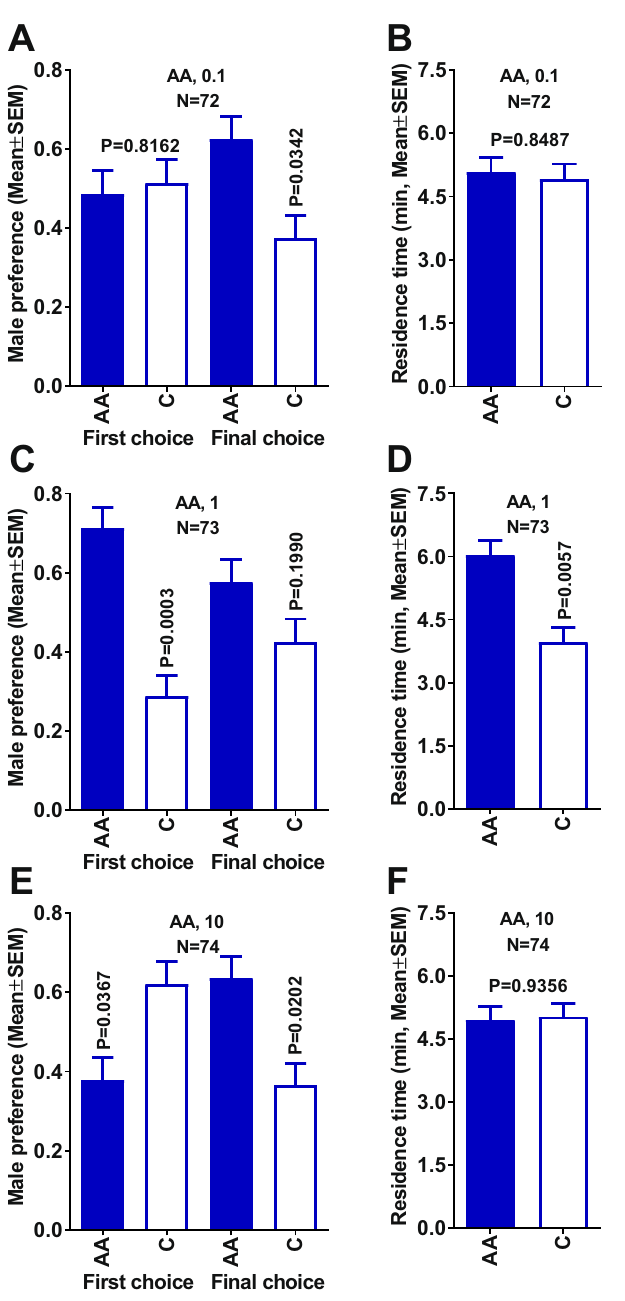
Figure 3. Behavioral responses of 7-day-old virgin males to acetic acid in a 4-way olfactometer. Male first and final choices when comparing treatments with ( A ) 0.1, ( C ) 1, and ( E ) 10 µ g of acetic acid vs. control. Comparison of residence times in each treatment vs. control with acetic acid at ( B ) 0.1, ( D ) 1, and ( F ) 10 µ g. Male preference indicates the proportion of males making first and final choice. Means were compared by Wilcoxon matched-pairs signed-rank tests. AA = acetic